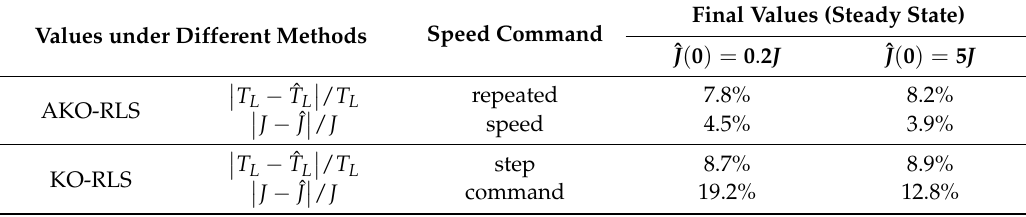
Figure 10. Comparison of two algorithms with initial value ˆ J ( 0 ) = 5 J and 1.2 Nm load torque, random step speed command. ( a ) Speed response (blue); ( b ) Observed load torque ˆ T L (black line denotes AKO-RLS result, red line denotes KO-RLS result); ( c ) identified moment of inertia ˆ J (black line denotes AKO-RLS result, red line denotes KO-RLS result). Table 4. Experiment Identification Results (under 1.2 Nm and repeated speed step command).